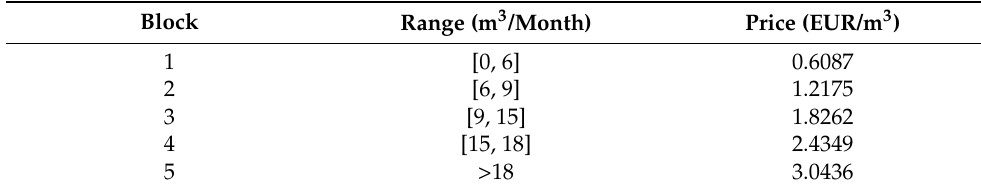
Table A6. Water tariff scheme (Source: [74]).